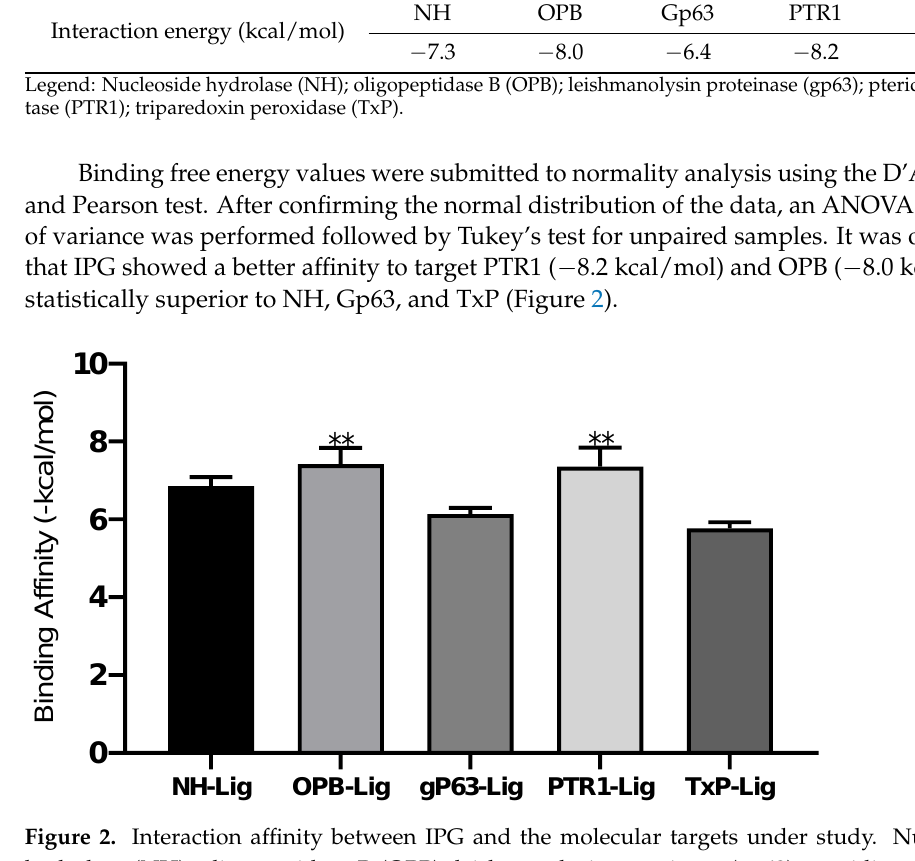
Table 2. Binding energies of IPG with L. major targets. GIP Molecule Targets Interaction